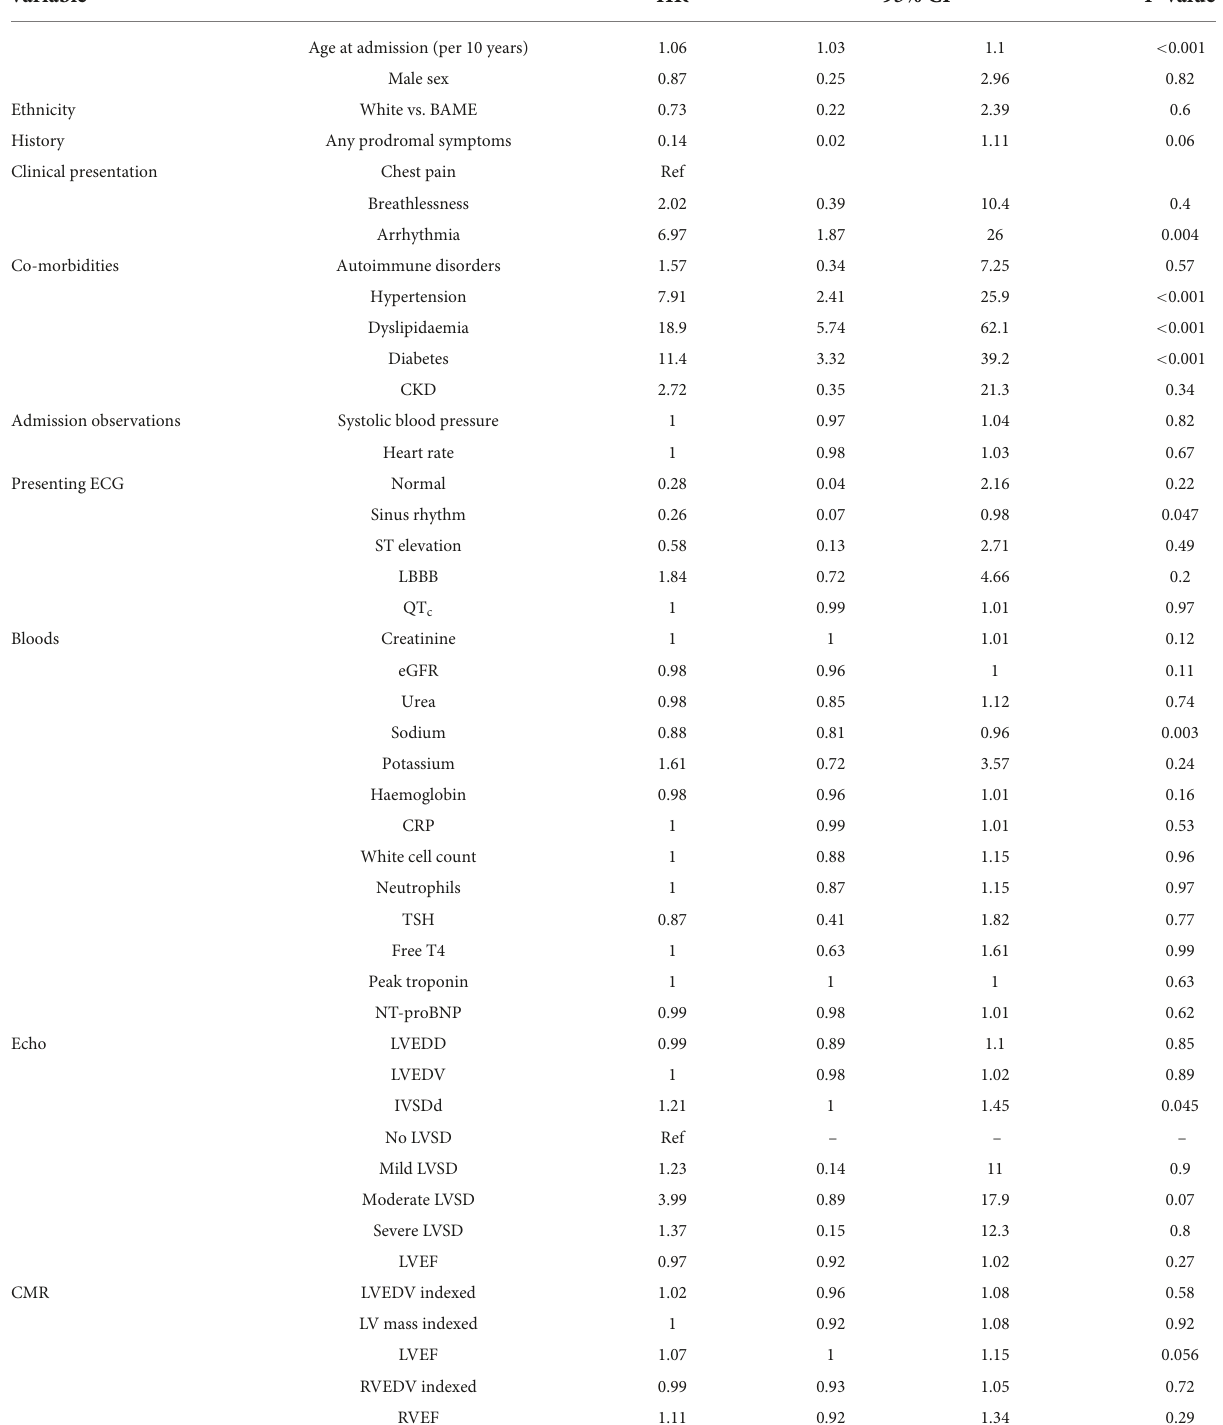
TABLE 5 Cox proportional univariable analyses evaluating the association of baseline characteristics with all-cause mortality, resuscitated cardiac arrest, and appropriate implantable cardioverter defibrillator (ICD) therapy following hospital discharge. Variable